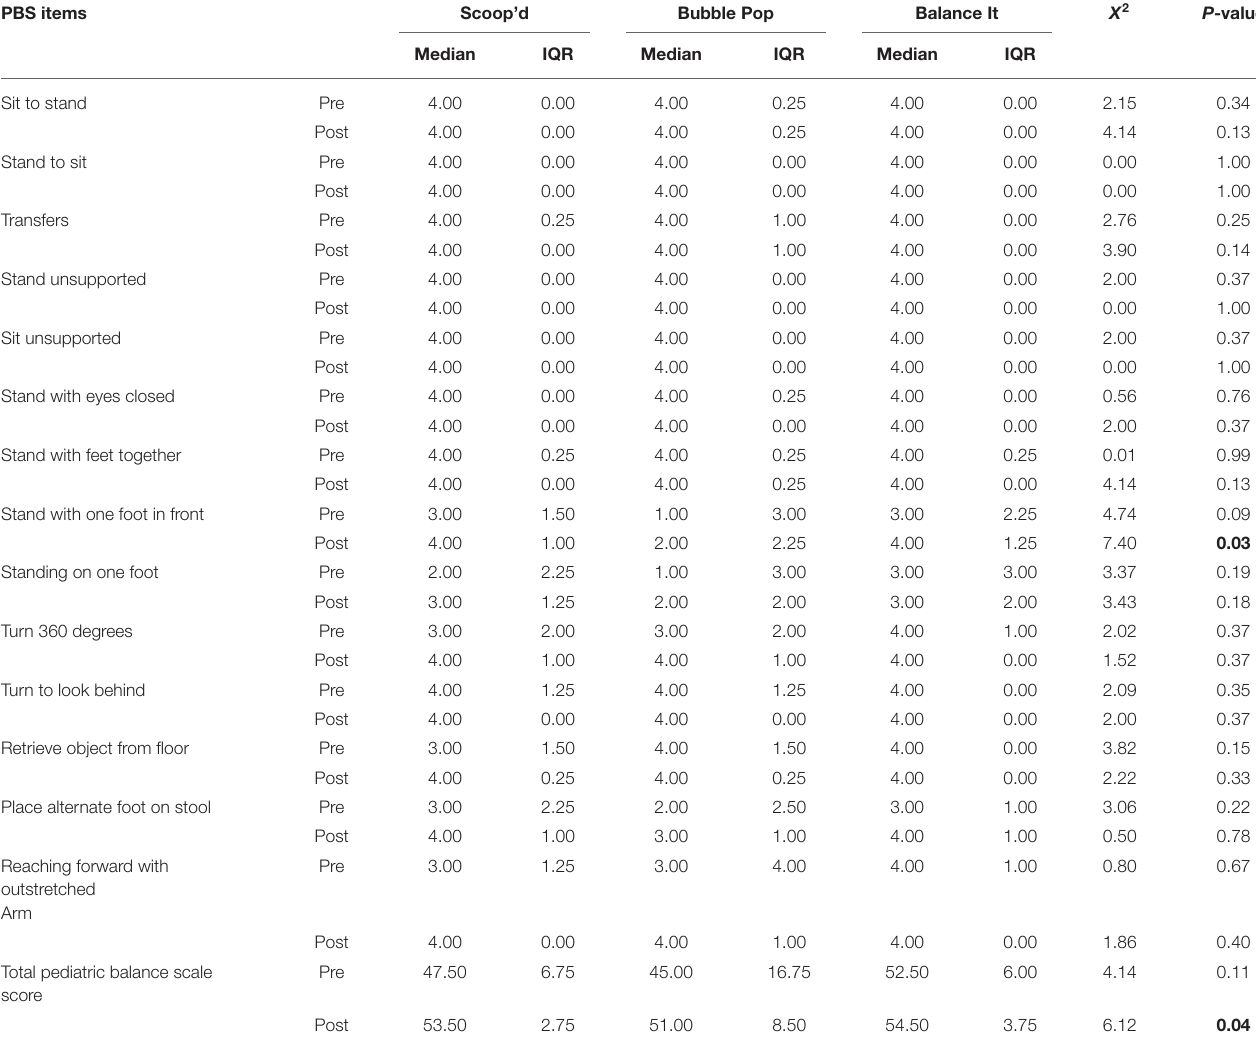
TABLE 3 | Between the groups’ analysis of PBS (Pre- and Post-intervention). PBS items Scoop’d Bubble Pop Balance It X 2 P -value Median IQR Median IQR